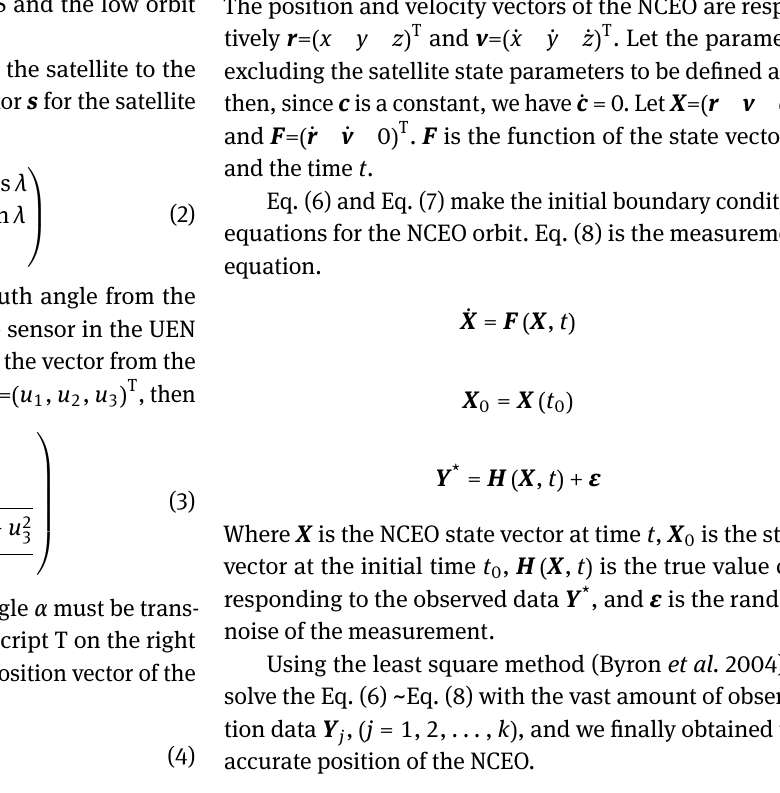
ECF, and the positions of the sensor S and the low orbit target M are shown in Figure